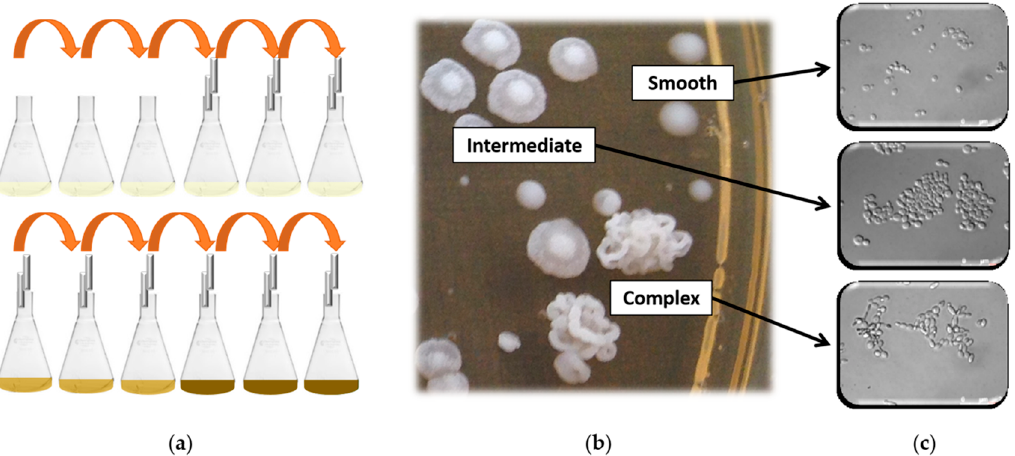
Figure 2. Isolation and morphological characterization of C. intermedia . ( a ) Simplified scheme of the adaptive laboratory evolution setup from which C. intermedia clones were isolated. Different colonies and cell morphologies of a mixed, xylose-growing population, in ( b ) solid and ( c ) liquid media. Clones were isolated at 30 °C from plates with synthetic medium supplemented with 20% ( v / v ) wheat straw hydrolysate. Selected colonies were grown in a synthetic liquid medium (without lignocellulosic hydrolysate) at 30 °C for 24 h. The images were obtained by optical microscopy at 100× magnification. Representative C. intermedia colonies of each morphology were grown in liquid synthetic